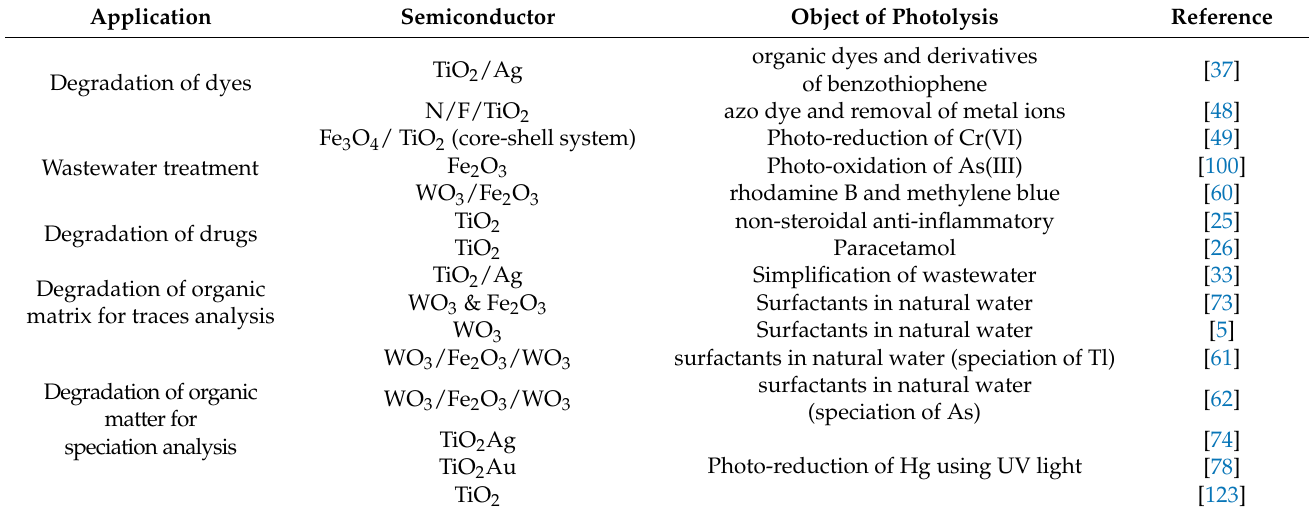
Table 1. The examples of applications of photoactive materials for decomposition of organic matter prior to water analysis or